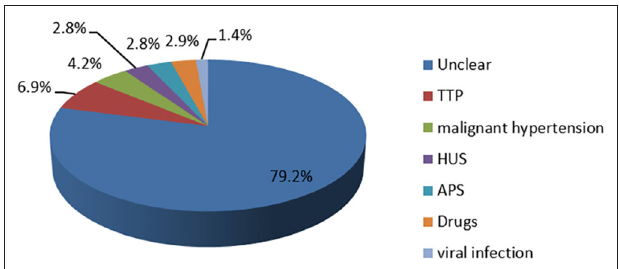
FIGURE 1 | The reasons for TMA in 72 patients. Fifteen patients (20.8%) were found with definite causes, the other 57 cases (79.2%) remained with unclear reasons.